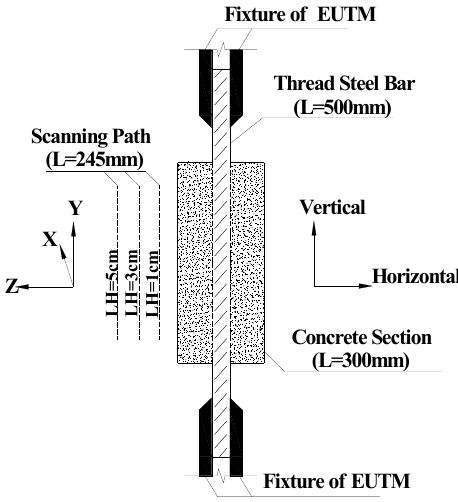
Figure 5. Schematic diagram of the scanning path of the magnetic sensor in the axial scanning test.